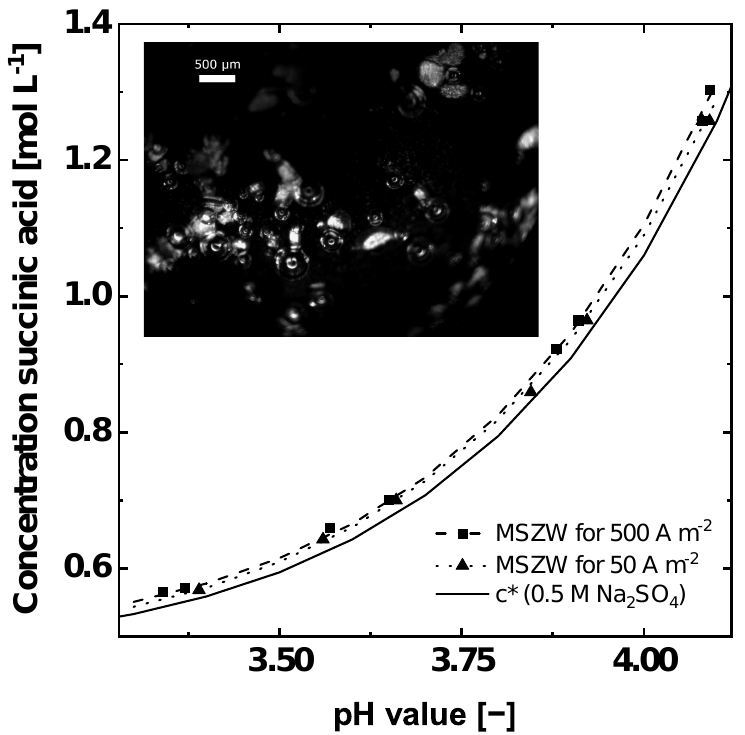
Figure 5. MSZWs of succinic acid for different current densities ( ■ ▲ ) along the solubility curve (Equation (16)). An exemplary image of the detected nucleation on the surface of the anode obtained with the borescope